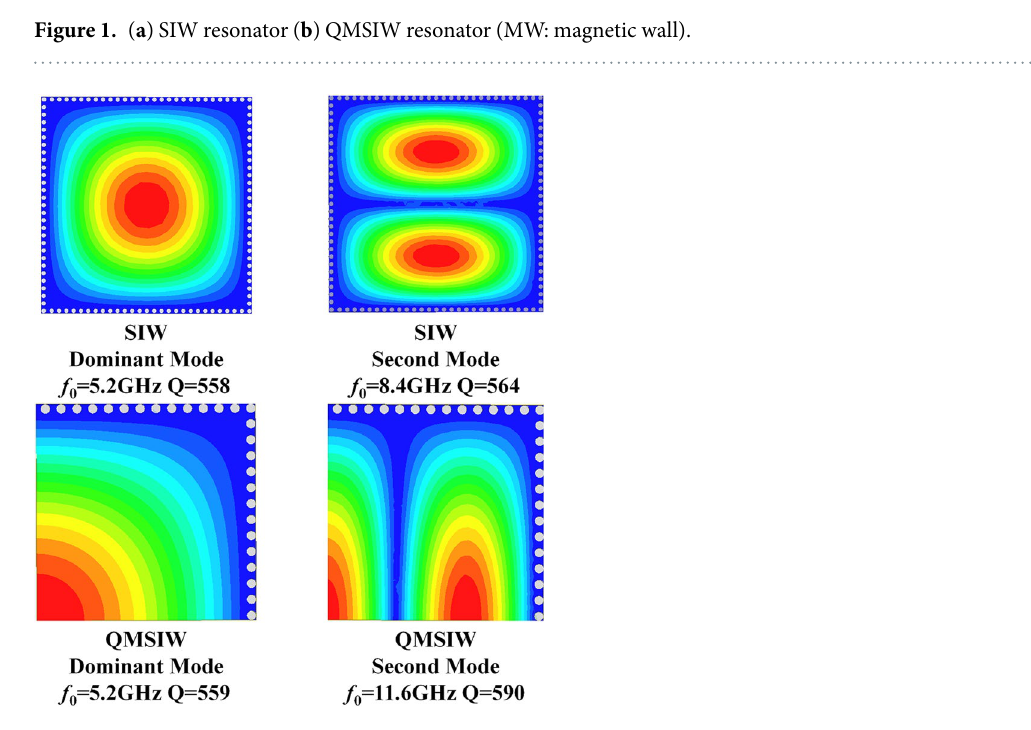
Figure 2. Comparison between SIW resonator and QMSIW